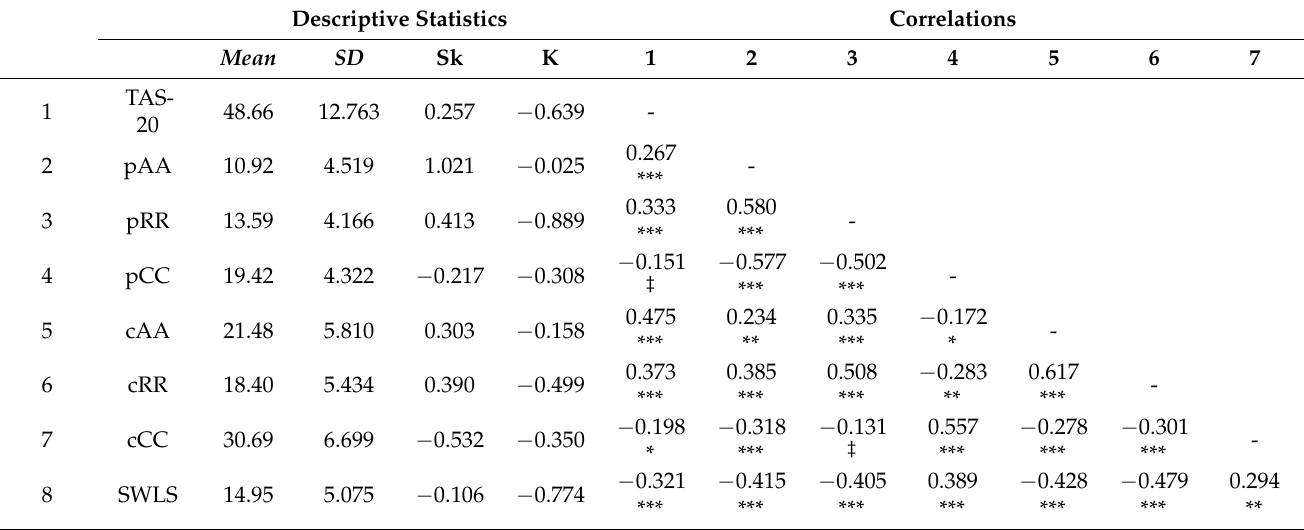
Table 1. Descriptive statistics of questionnaires (row scores) and correlations between